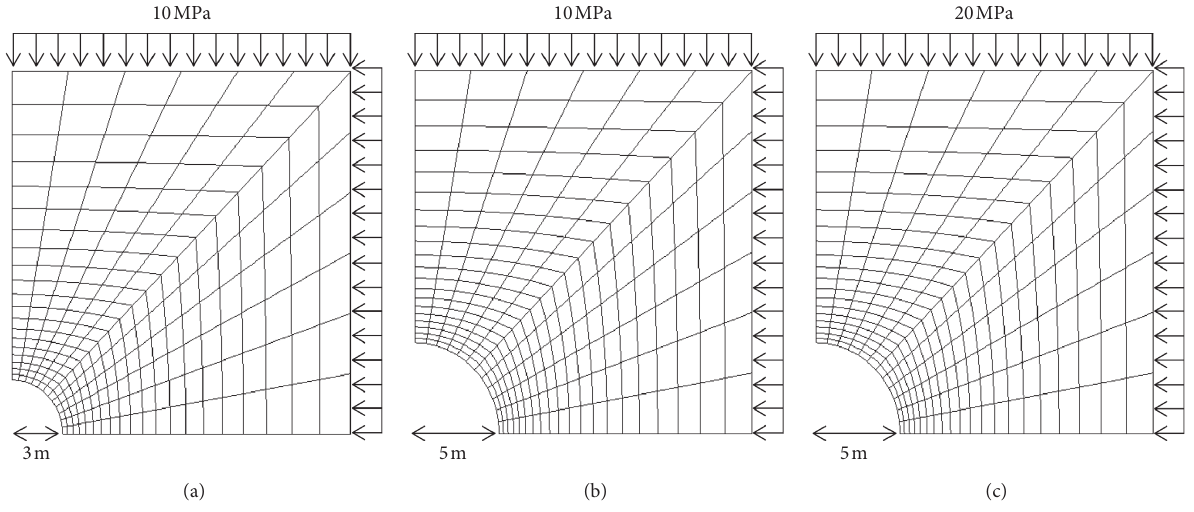
Figure 5: Numerical model cases for the DEA calculations (displacement-based).